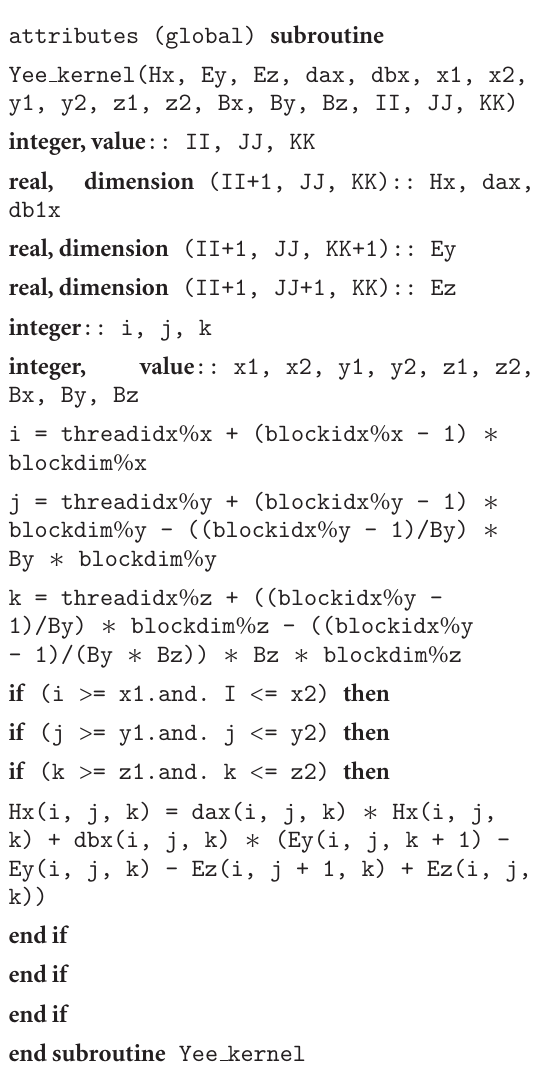
Table 2: GPU kernel throughput for the standard FDTD algorithm at several thread-block size